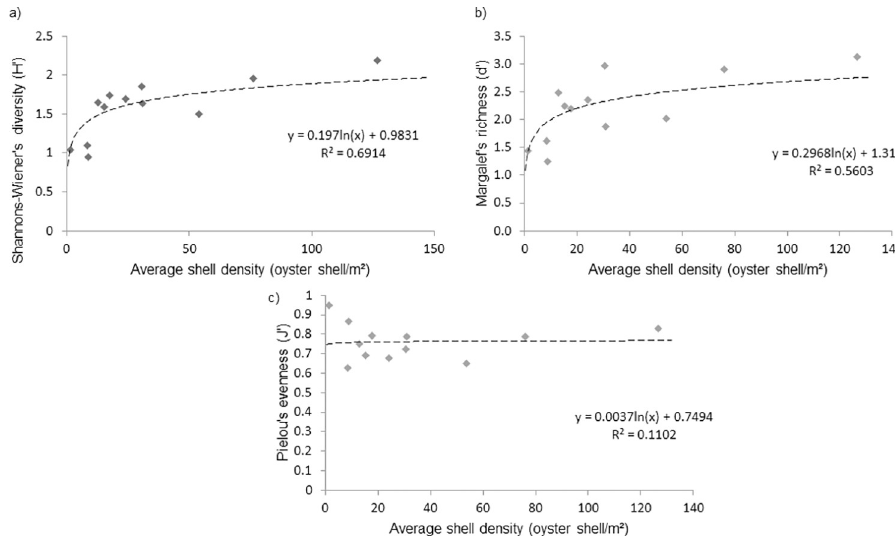
Fig 6. Regression models comparing biodiversity indices against shell density a) Shannon-Wiener diversity b) Margalef’s richness c) Pielou’s